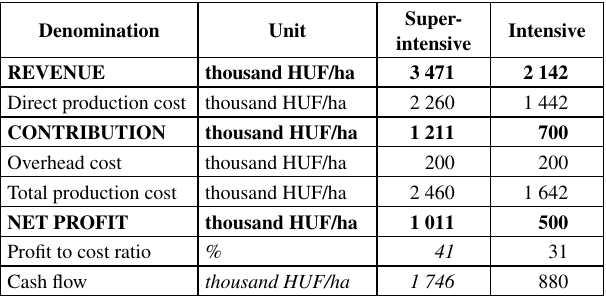
Table 3: Profit and Profitability in Apple Orchards Cultivated on a High Standard in a Year without Extremities